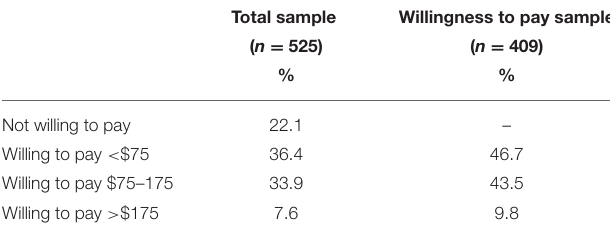
TABLE 2 | Micro-Level social value perspective: reverse contingent valuation